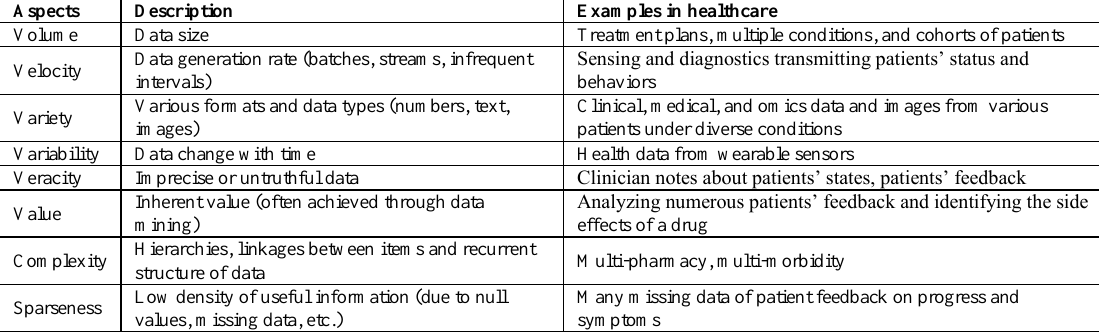
Table 4. Big data